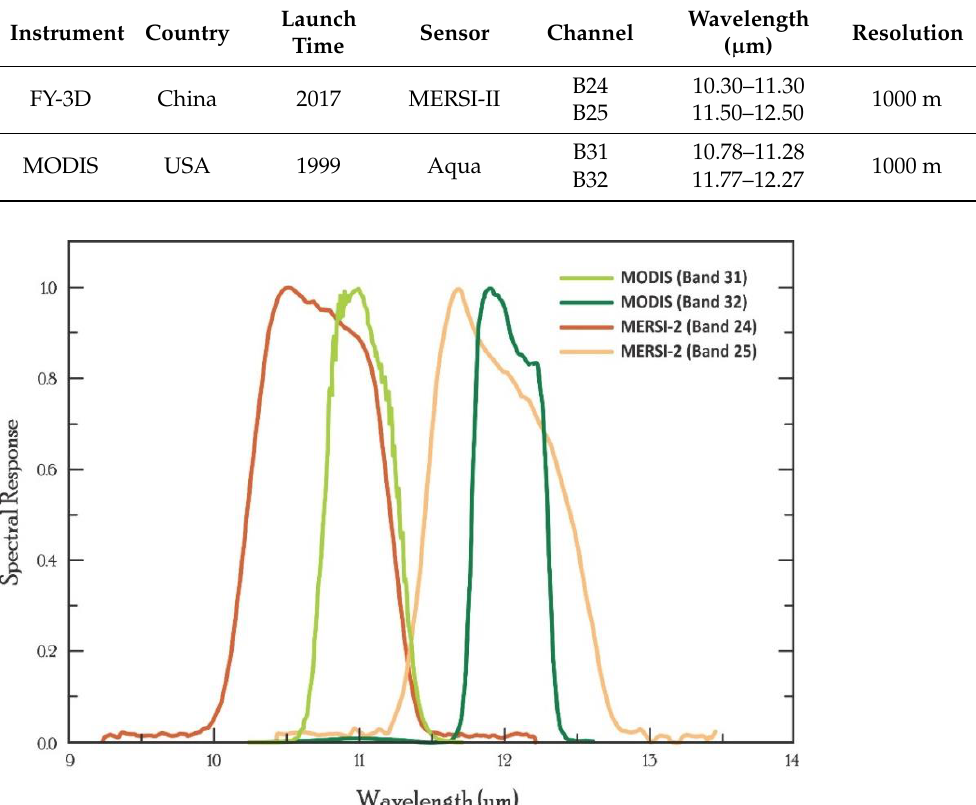
Table 1. FY-3D sensor characteristics that correspond to the MODIS TIR Bands are commonly used for retrieving land surface temperature.